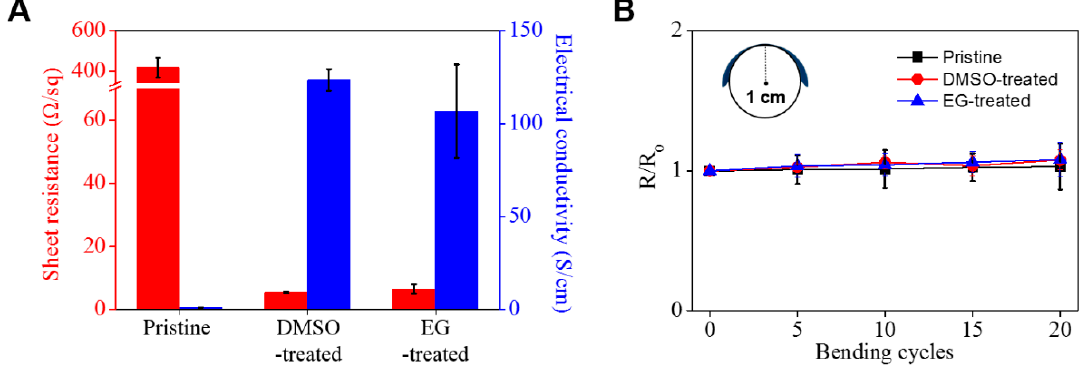
Figure 4. ( A ) Sheet resistance, electrical conductivity, and ( B ) bending stability of PEDOT:PSS/CNF porous nanocomposite paper before and after post-treatment with EG and DMSO.